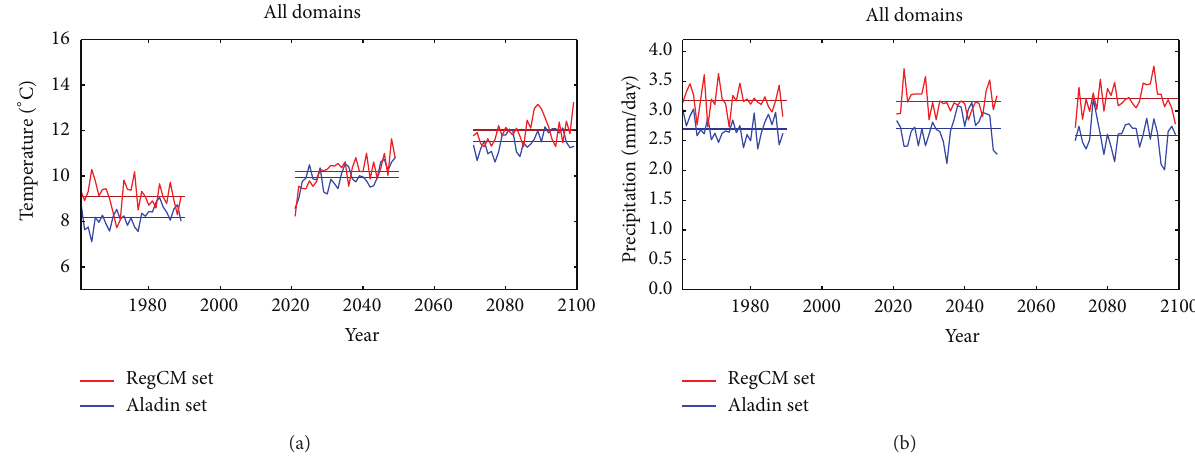
Figure 16: Average 2 m temperature (a) and precipitation (b) over common CECILIA domain; annual average (thin line) and 30-year average (thick line).